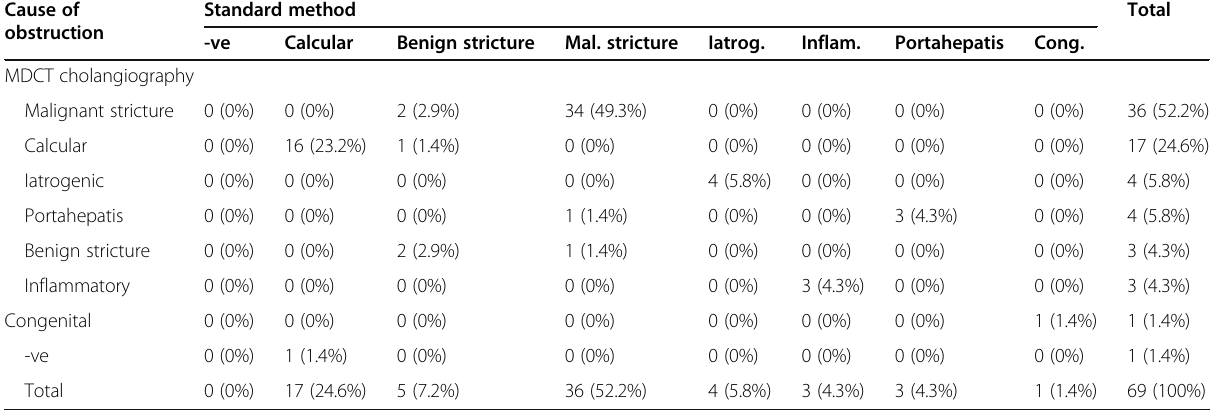
Table 6 Agreement between MDCT cholangiography and gold standard method in the detection of the cause of obstruction Cause of obstruction